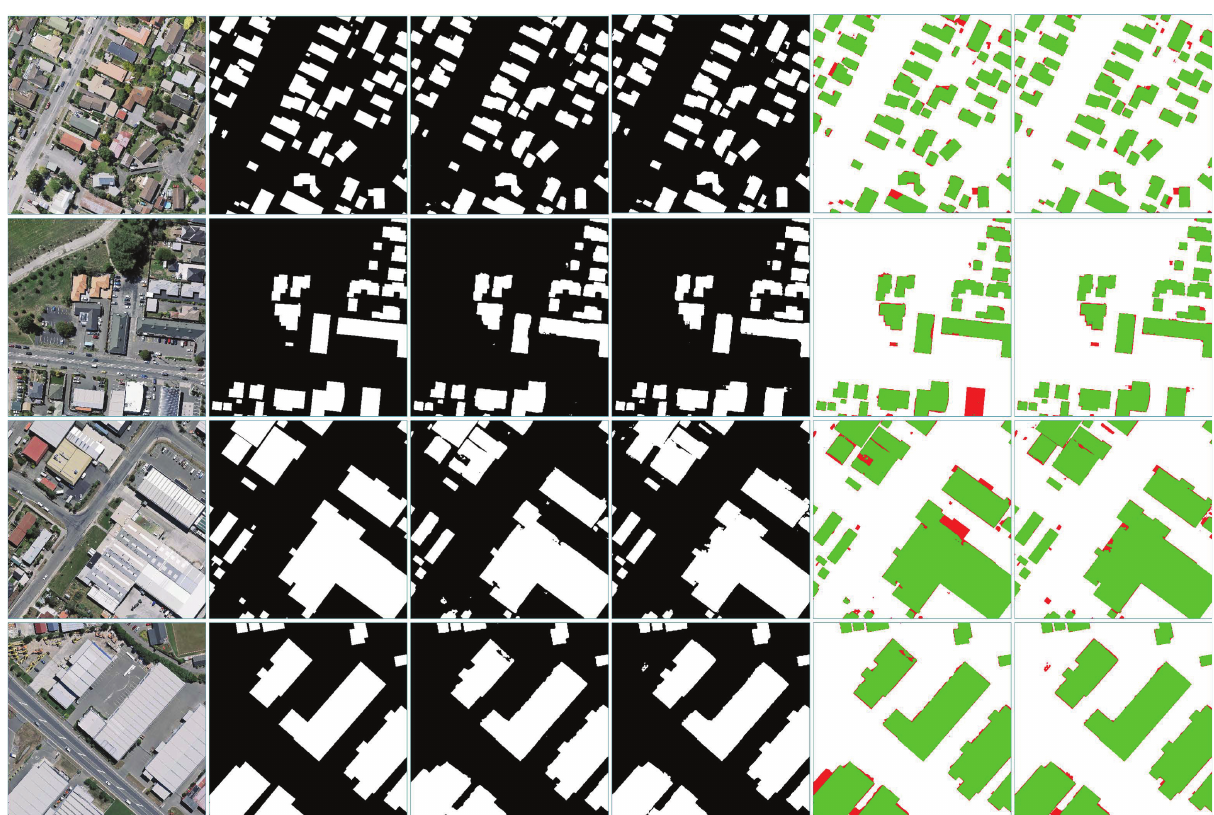
Figure 9. Examples of building extraction produced by “w/B” and “B”. From left to right: aerial images, labels, predictions of “w/B”, predictions of “B”, errors of “w/B”, and errors of “B”. The weight ω i is set to